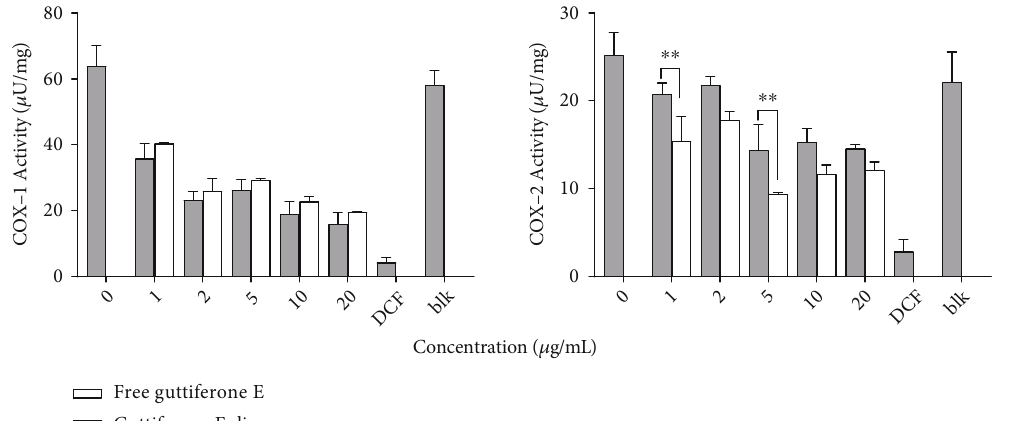
Figure 6: Detection of COX-1 and COX-2 activity in LPS-stimulated MH-S cell lysate treated with di ff erent concentrations of free guttiferone E and guttiferone E-liposomes. The positive control diclofenac (DCF) was used at 5 μ M, and blank liposomes (blk) used as a vehicle control were tested at 20 μ g/mL. One unit (U) of COX activity is the amount of enzyme that generates 1.0 μ mol of resoru fi n per minute at pH 8.0 and 25 ° C. Data are the mean from three independent experiments. Dunnett ’ s multiple comparisons test using two-way ANOVA was performed: ∗ p < 0 : 01 , ∗∗∗ p < 0 : 001 , and ∗∗∗∗ p < 0 : 0001 for free guttiferone E versus guttiferone E-loaded